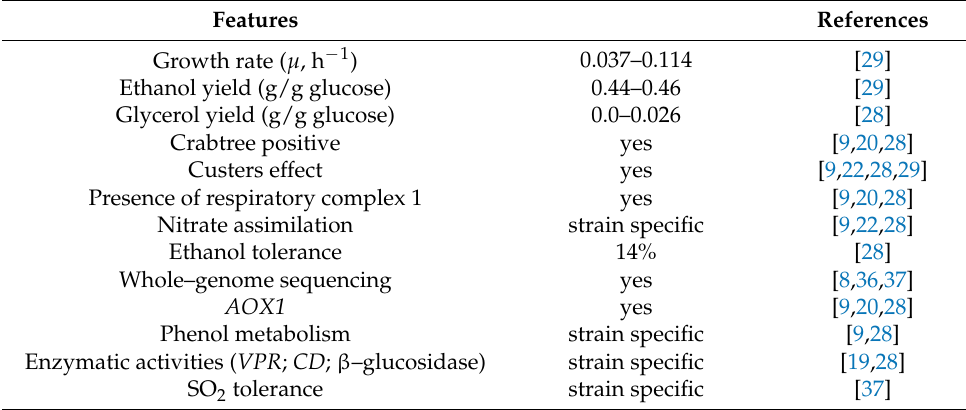
Table 1. Physiological and metabolic features of B. bruxellensis